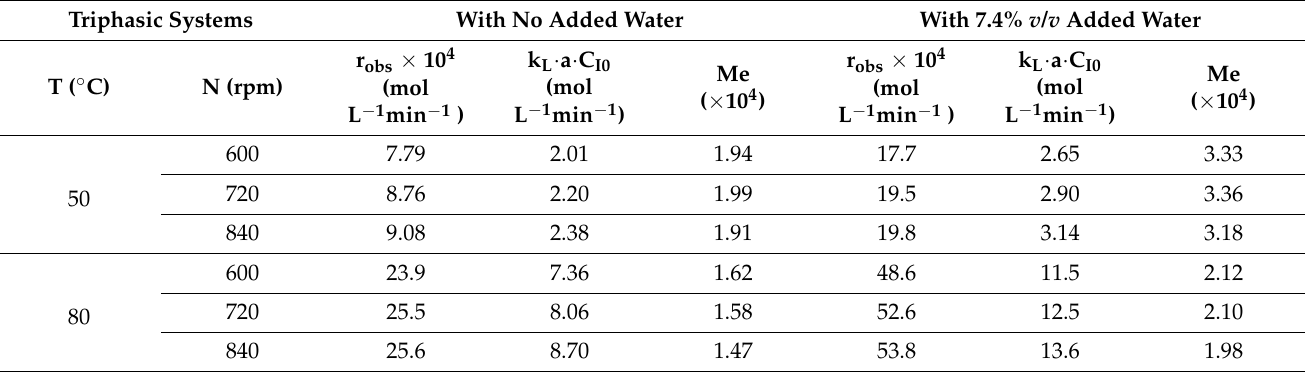
Table 2. Measured initial reaction rate (r obs ), mass transfer flow as a product of the volumetric mass transfer coefficient (k L · a) and the ibuprofen concentration in bulk (C I0 ) and Mears parameter (Me) of the glycerin–toluene mixture (without and with 7.4% v / v added water) estimated over the operating temperature